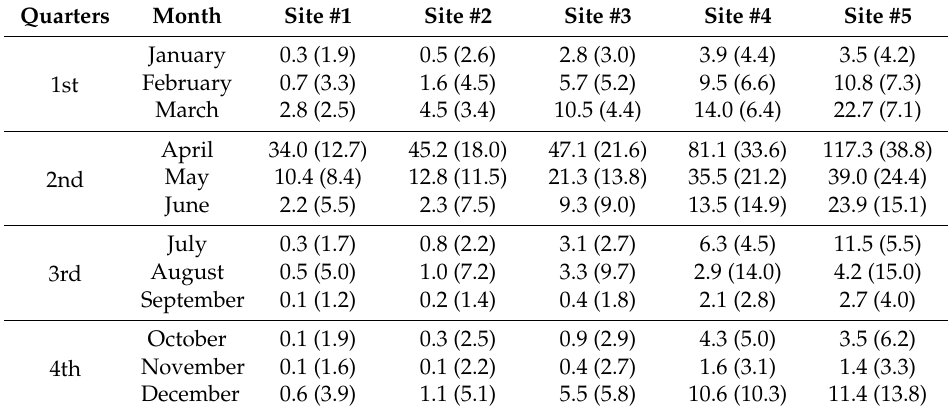
Table 5. Median maximum monthly flow statistics calculated from SWAT-simulated pre-settlement flow (shown parenthetically) and observed developed flow in Hinkson Creek, MO, USA.